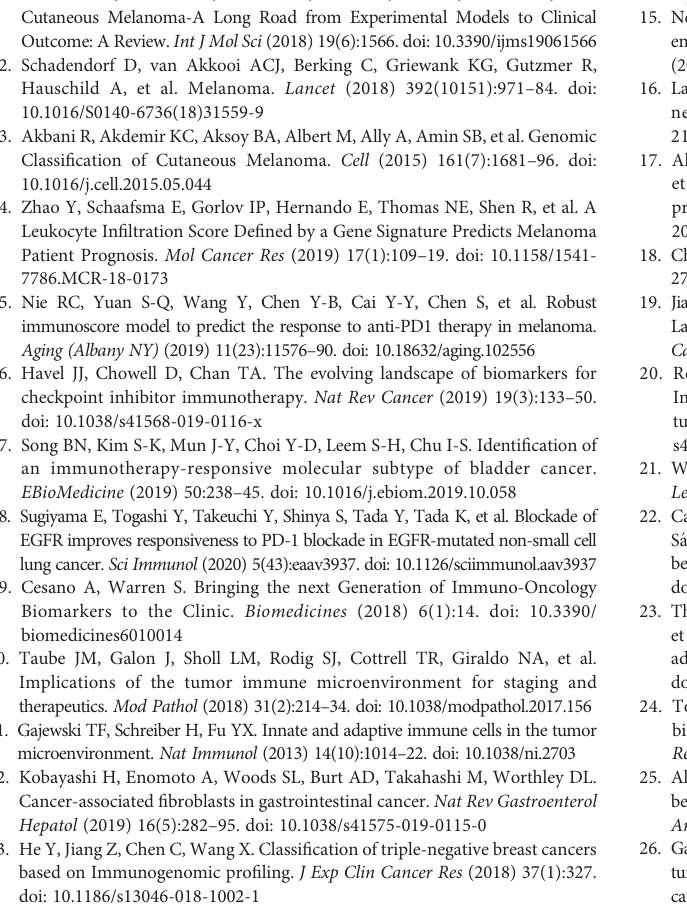
SUPPLEMENTARY TABLE 1 | Stromal scores, immune scores, estimate scores and tumor purity of each sample.